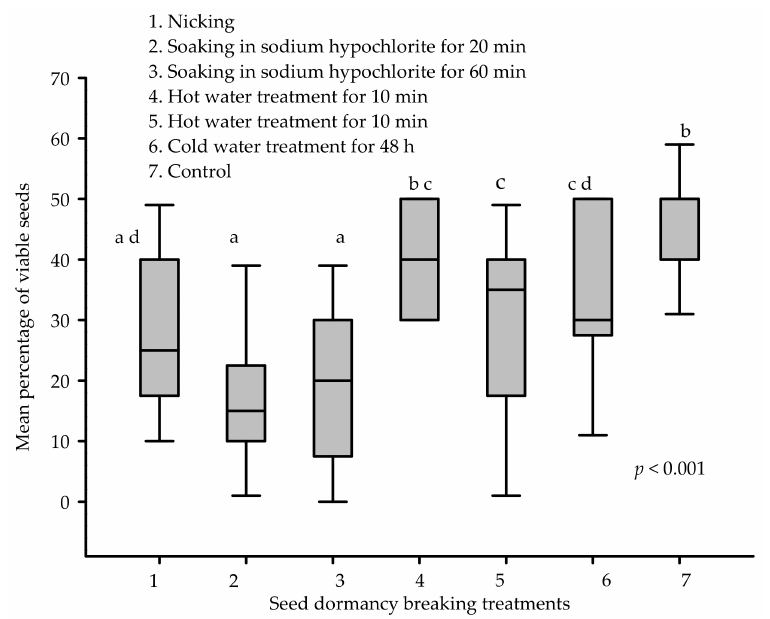
Figure 9. The one-way ANOVA results for the relative mean percentages of viable seeds among the different seed-dormancy-breaking treatments of D. steudneri at the end of the experiment in the seed